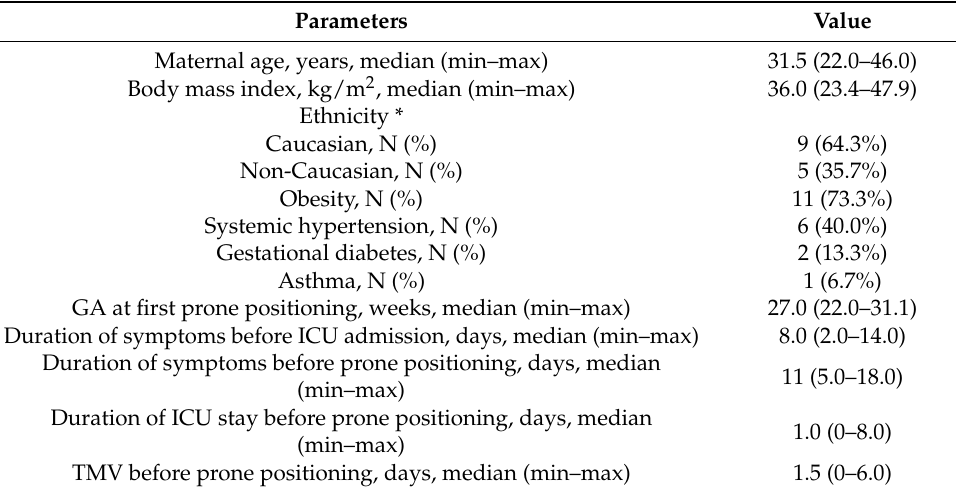
Table 1. Demographic, clinical, and obstetric parameters of pregnant women undergoing prone positioning ( n = 16). Parameters Value Maternal age, years, median (min–max) 31.5